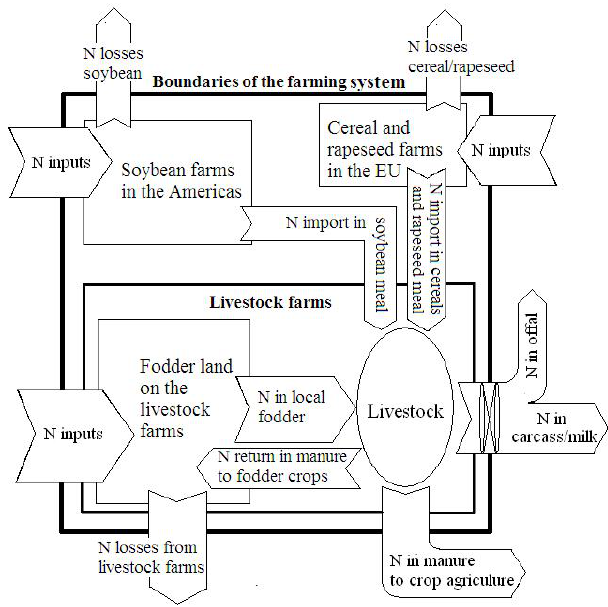
Fig. 3. The N cycle in spatially scattered livestock systems.